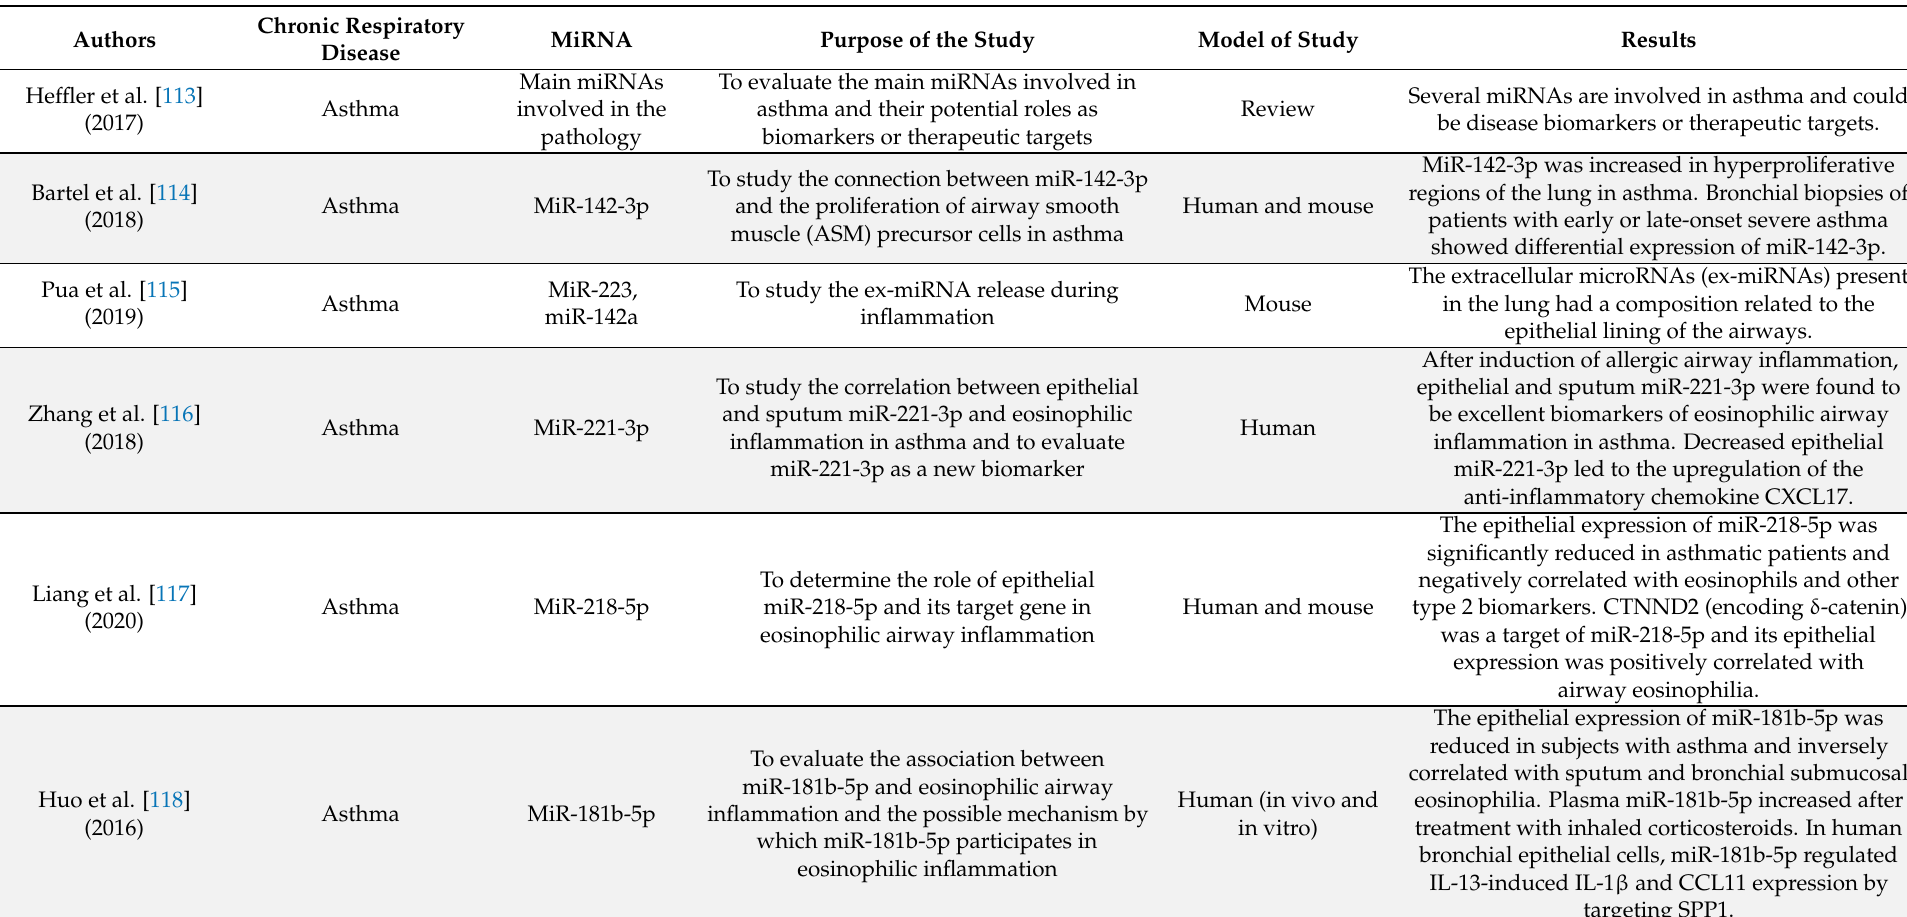
Table 2. Effects of miRNAs on respiratory